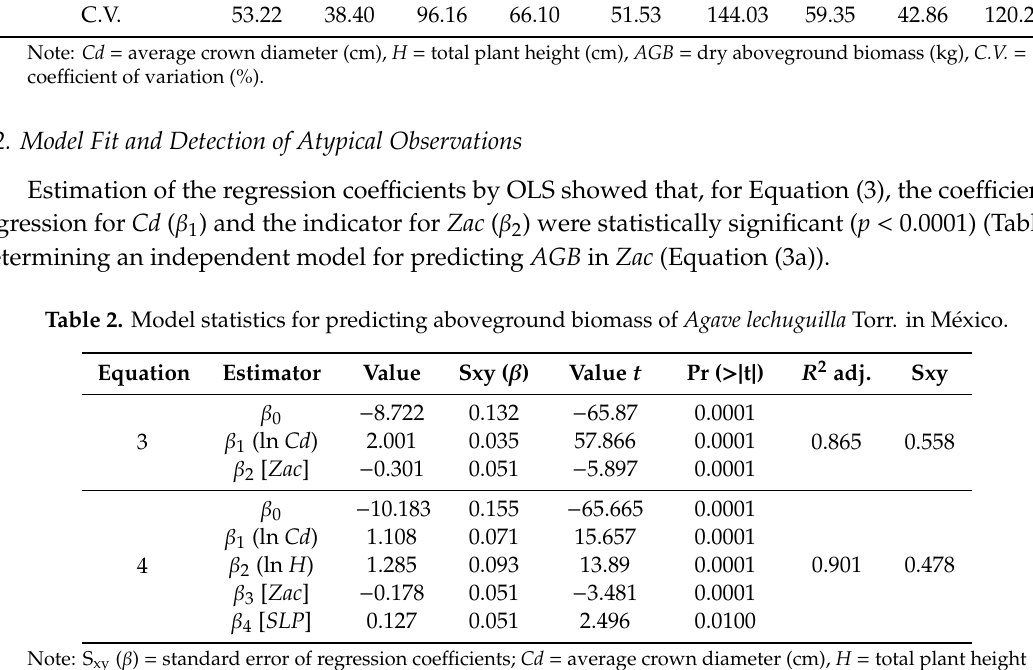
Standard deviation